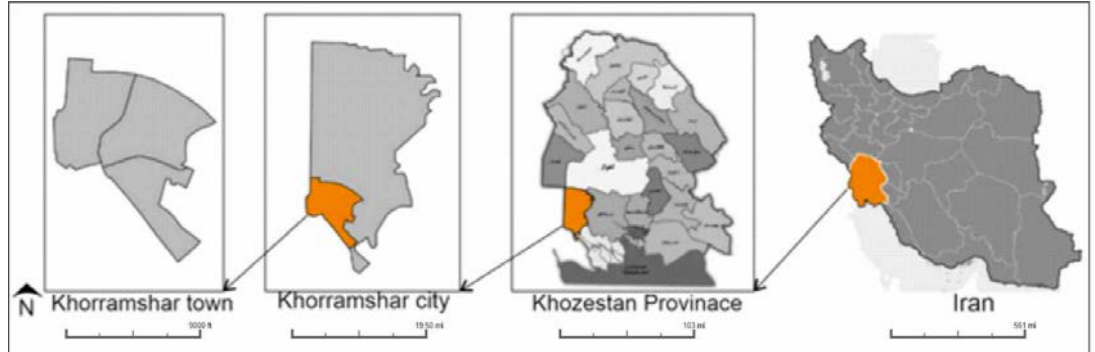
Fig. 1: Geographical location of Khorramshahr in the country and Khuzestan province